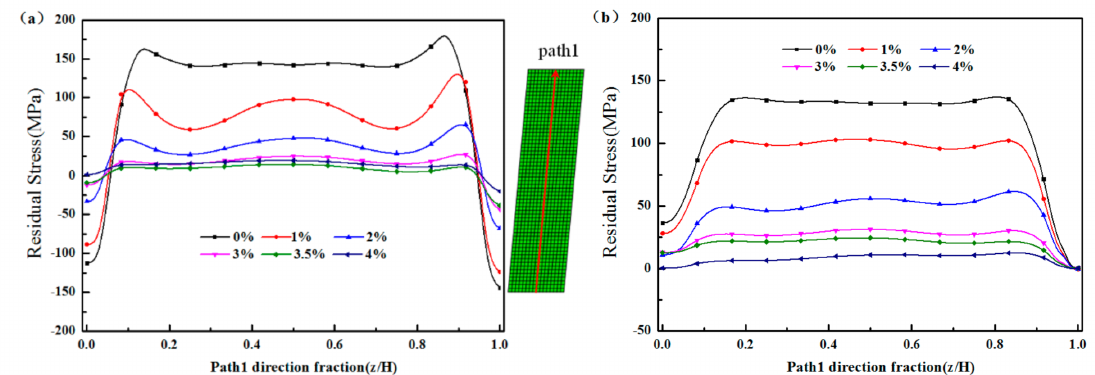
Figure 10. Residual stresses of the quenched tapered cylinder forgings along path 1 under different cold bulging ratio conditions: ( a ) σ t and ( b ) σ z .